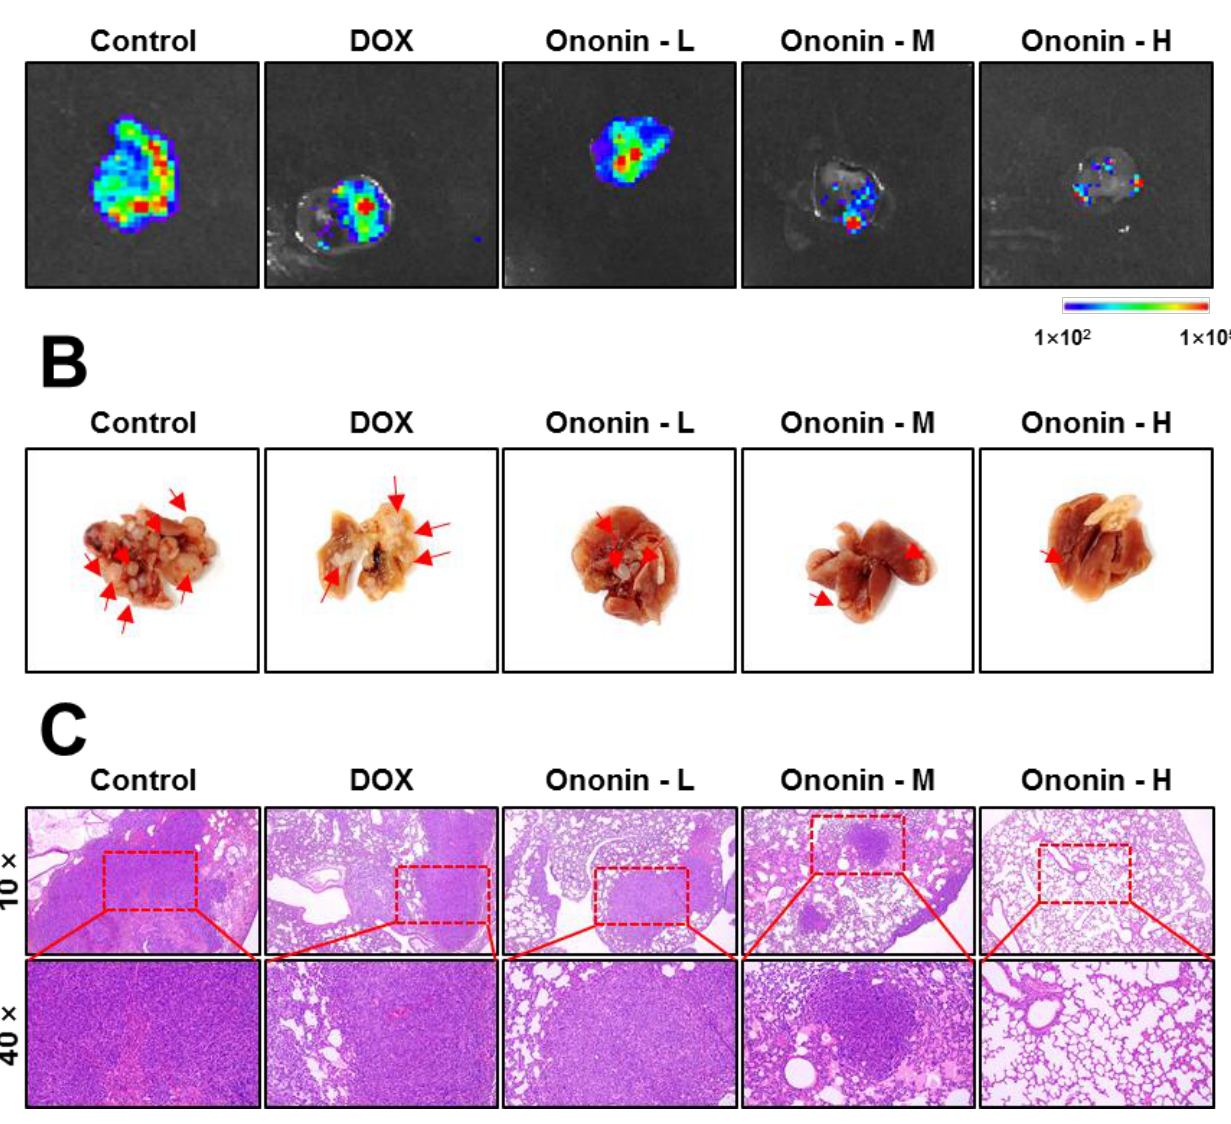
Figure 7. ( A ) Bioluminescence imaging of the separated lungs from each group of MG-63 xenograft nude mice. ( B ) Images of lungs from various groups and treatments. ( C ) The lung has been stained with HE. Ononin at 1, 3, and 10 mg/kg/i.p were shown as -L, -M, and -H, respectively. The lungs were fixed after autopsy, and the number of lung metastases were marked (red arrow) in Figure 7B. Additionally, lung metastasis was significantly larger in the control group than in the ononin or DOX treatment groups when the lung tissue was stained